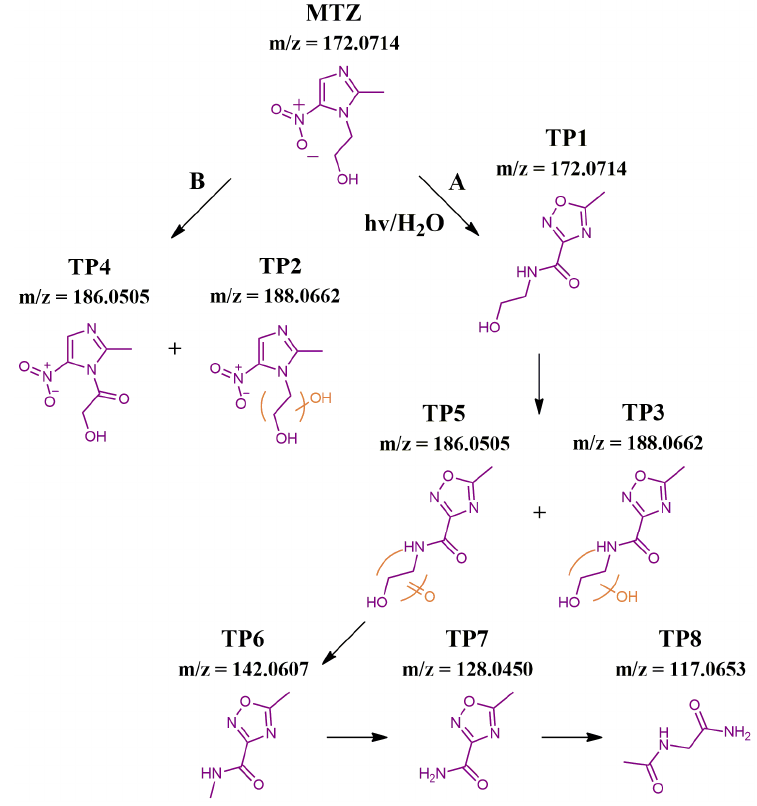
Scheme 1. Proposed transformation pathways of MTZ under lab scale